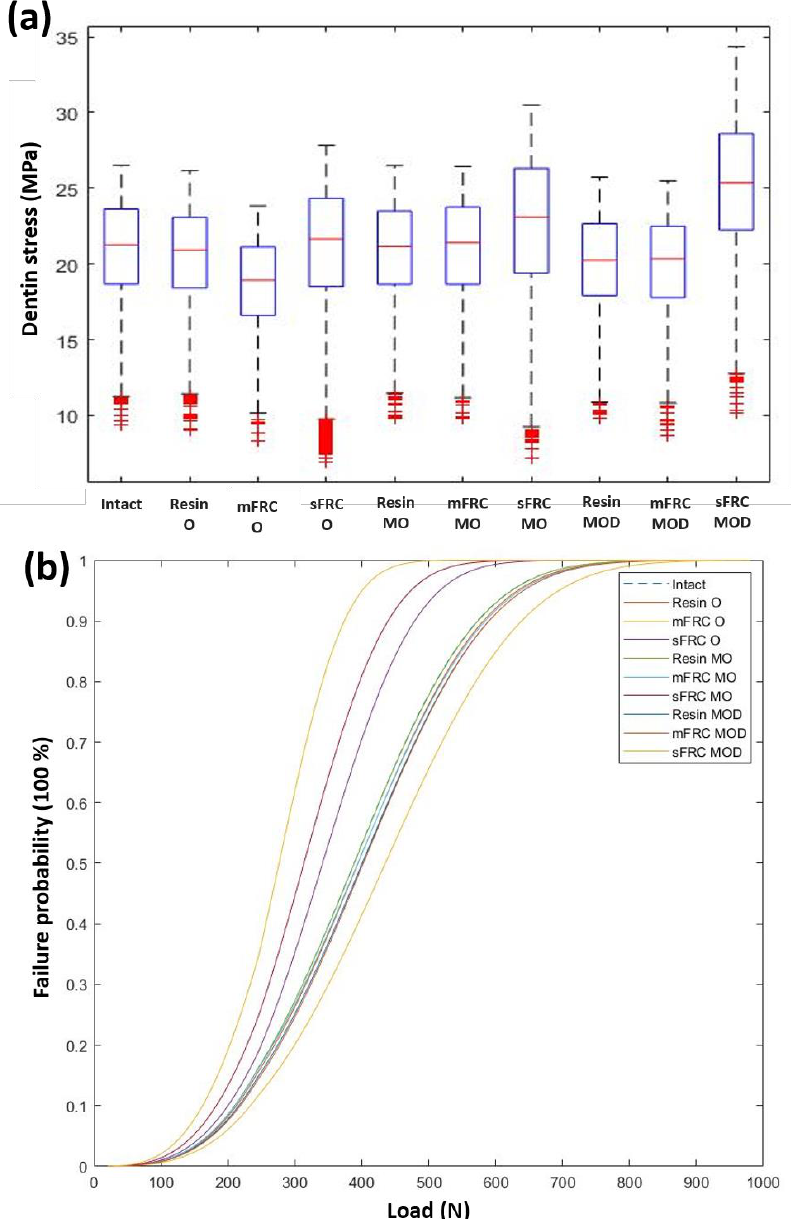
Figure 7. ( a ) Boxplot showing dentin stresses for three types of cavity: occlusal (O), mesio-occlusal (MO) and mesio-occluso-distal (MOD), and different restorative strategies: resin, multiple fiber-reinforced composite (mFRC) and single fiber-reinforced composite (sFRC). ( b ) Failure probabilities for three types of cavity: occlusal (O), mesio-occlusal (MO) and mesio-occluso-distal (MOD), and different restorative strategies: resin, multiple fiber-reinforced composite (mFRC) and single fiber-reinforced composite (sFRC).